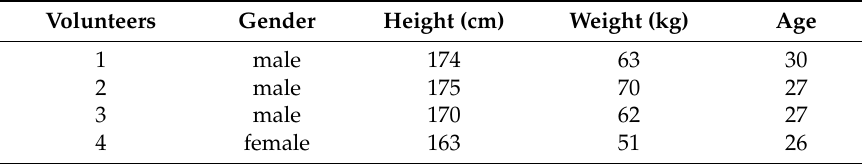
Table 1. Basic information of volunteers.